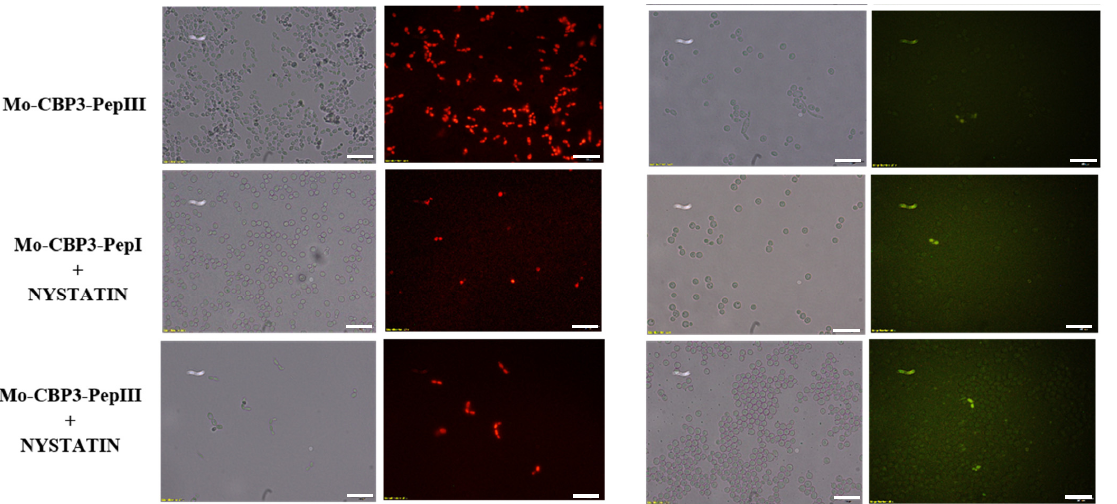
Figure 5. Fluorescence images showing membrane pore formation and ROS overproduction on inhibition of biofilm of C. albicans cells. Control solution of DMSO-NaCl, treated with Mo -CBP 3 -PepI and Mo -CBP 3 -PepIII at 50 μ g mL − 1 and synergistic activity of both peptides with NYS. Membrane pore formation was measured by the propidium iodide (PI) uptake assay, and ROS overproduction was detected using 2 ′ , 7 ′ dichlorofluorescein diacetate (DCFH-DA). Bars: 100 μ m.